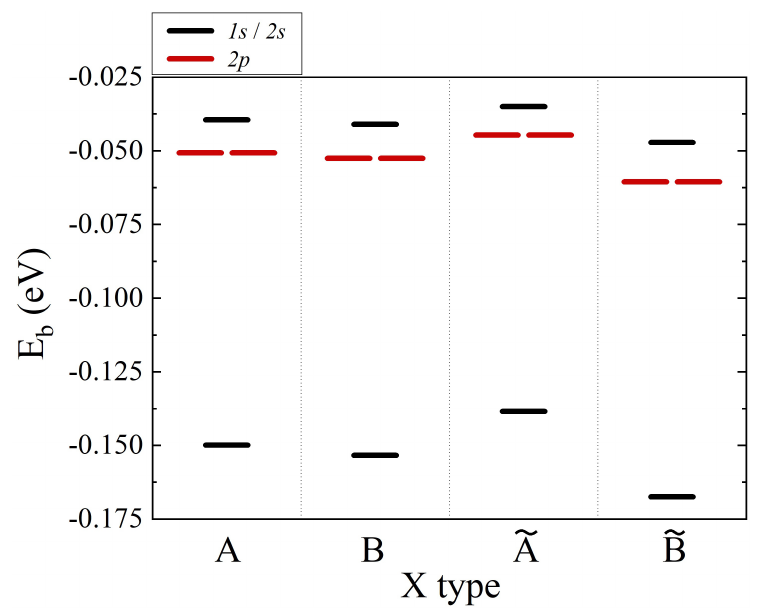
Figure 13. Interlayer exciton fine structure for the MoSe 2 /WSe 2 heterostructure encapsulated with hBN in the EMA, restricted to 1 s , 2 p , and 2 s states. Interlayer A/B/ ˜ A/ ˜ B exciton types have